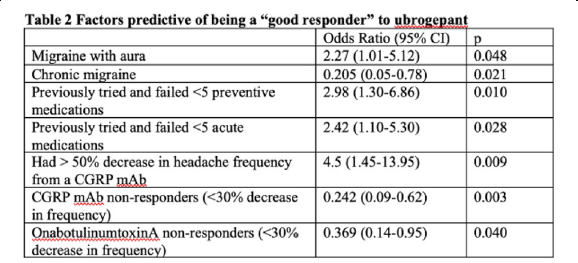
Table 2 (abstract P0259). See text for